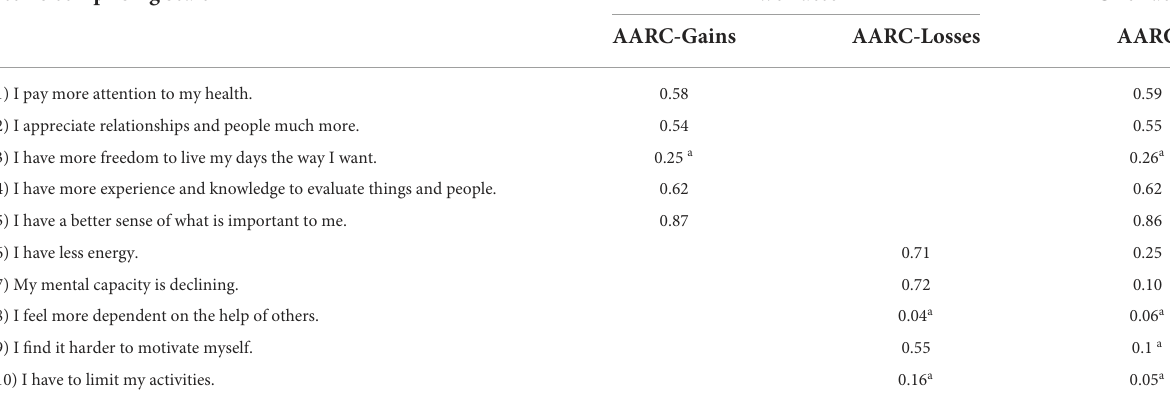
TABLE 2 Factor loadings of two- and one-factor models of AARC. Items comprising